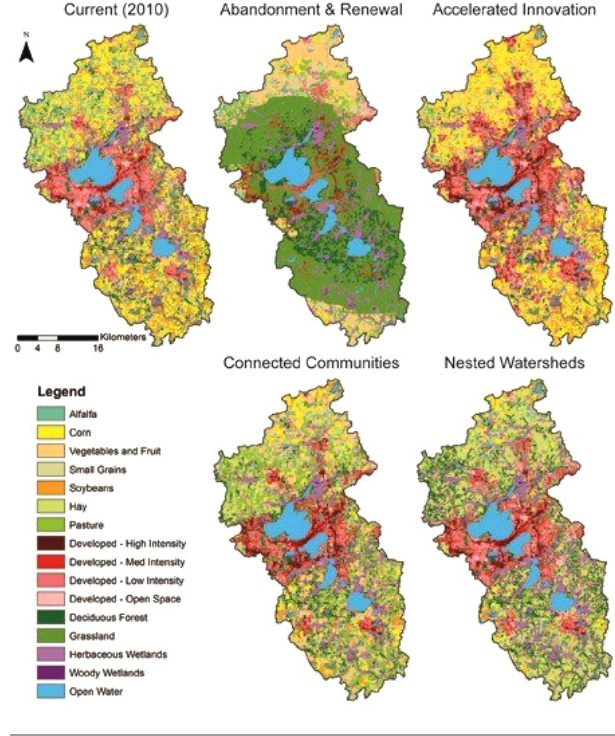
Fig. 9. Example of a portion of the climate driver time-series for the “Abandonment and renewal” scenario showing the matching of events (large flood and heat wave) to the qualitative narrative. Top panel: daily precipitation (black). Bottom panel: daily maximum (red) and minimum (blue) air temperature.